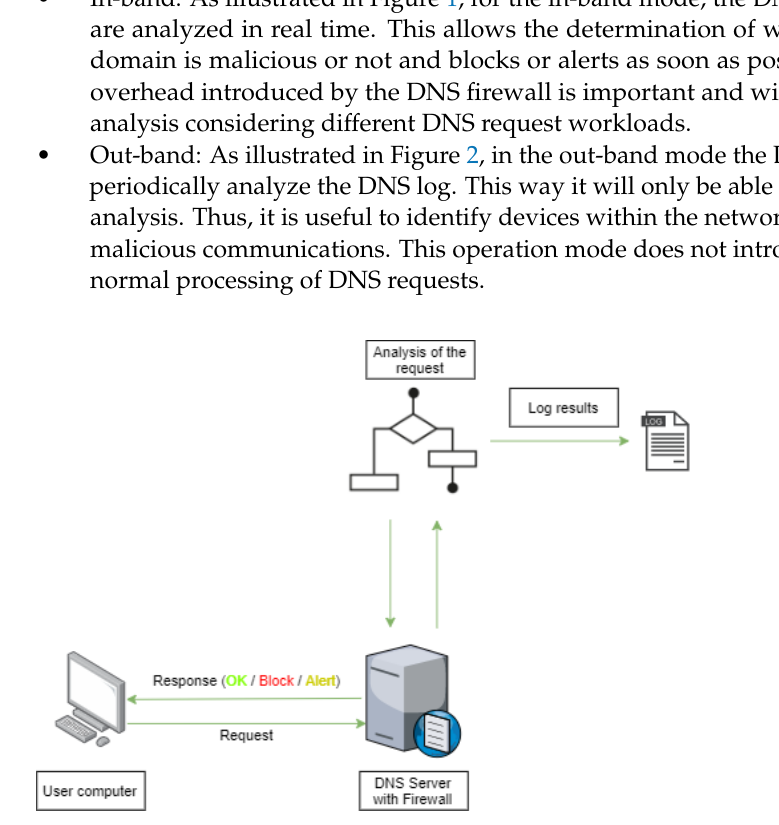
Figure 1. DNS Firewall operating in